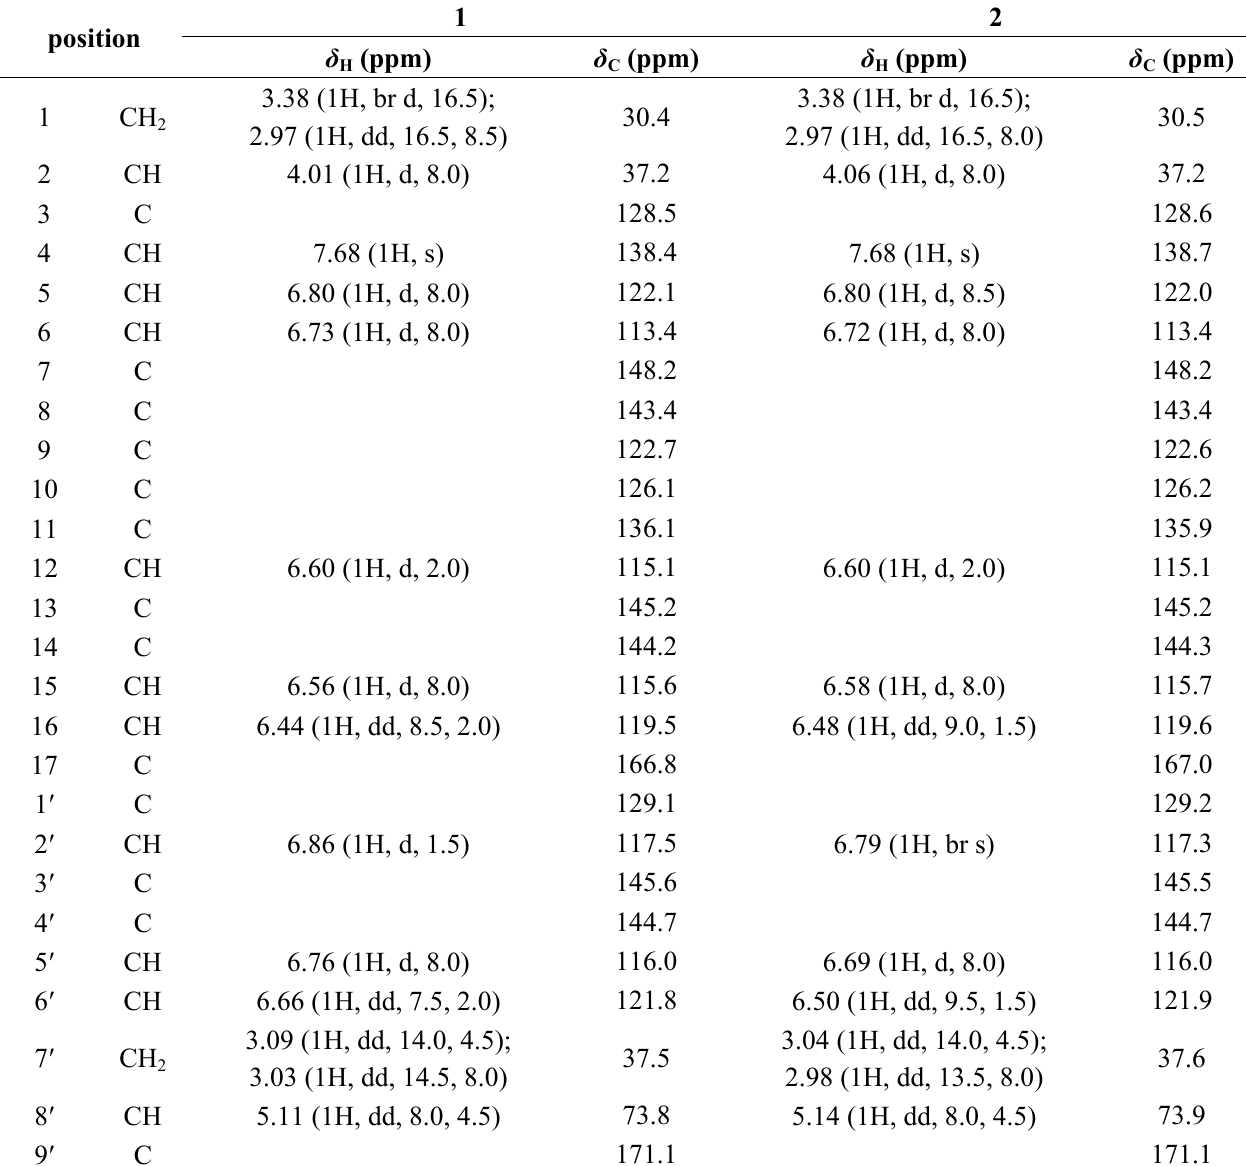
; 500 MHz for 1 H, 125 MHz for 13 6